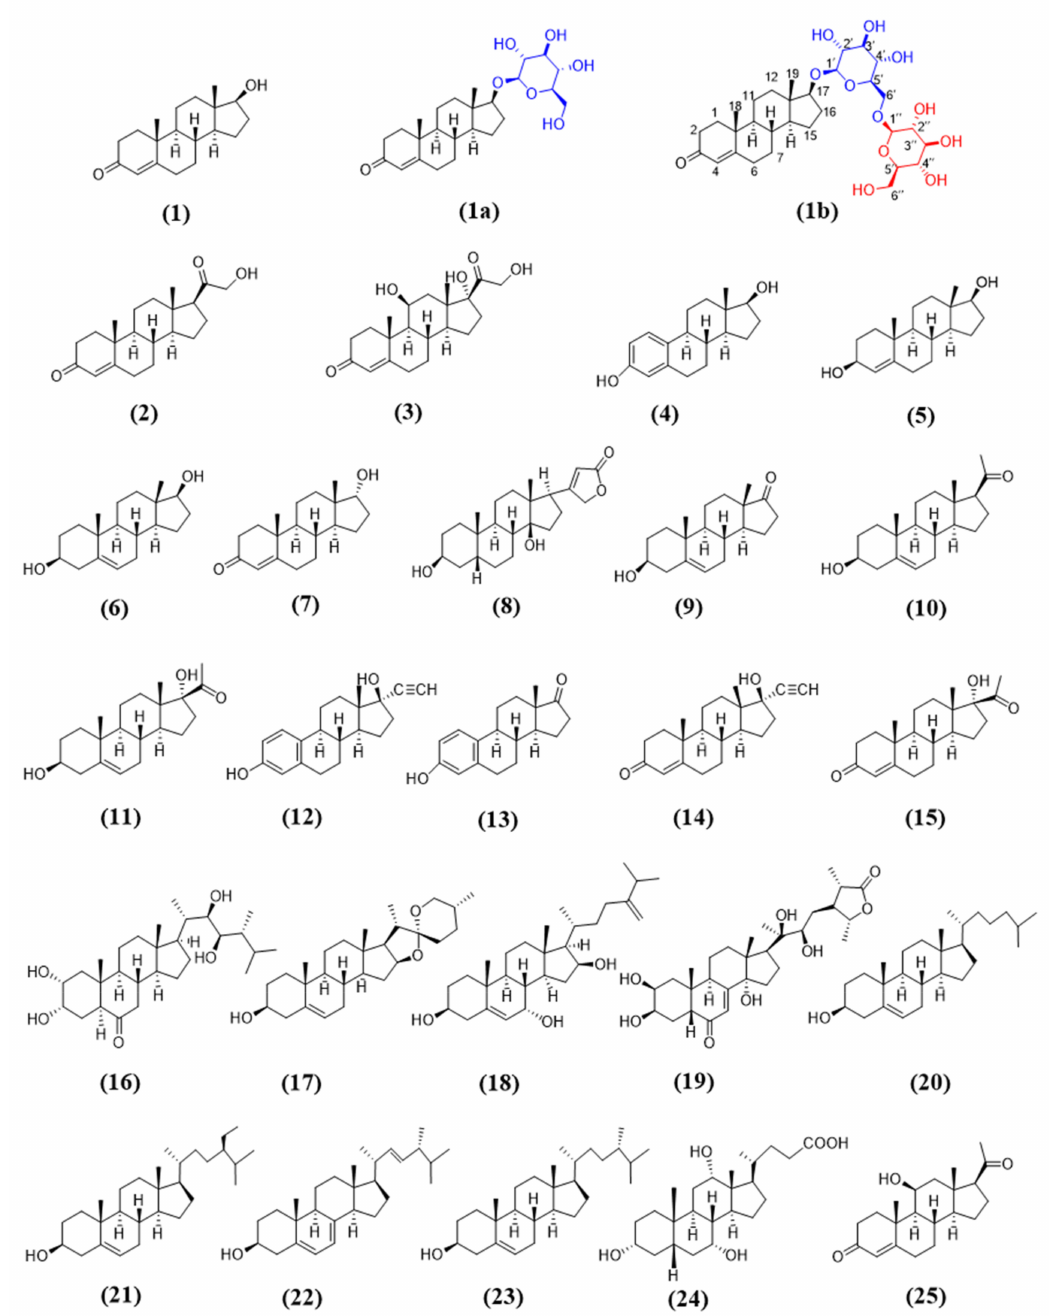
Figure 6. Steroidal substrates used in this